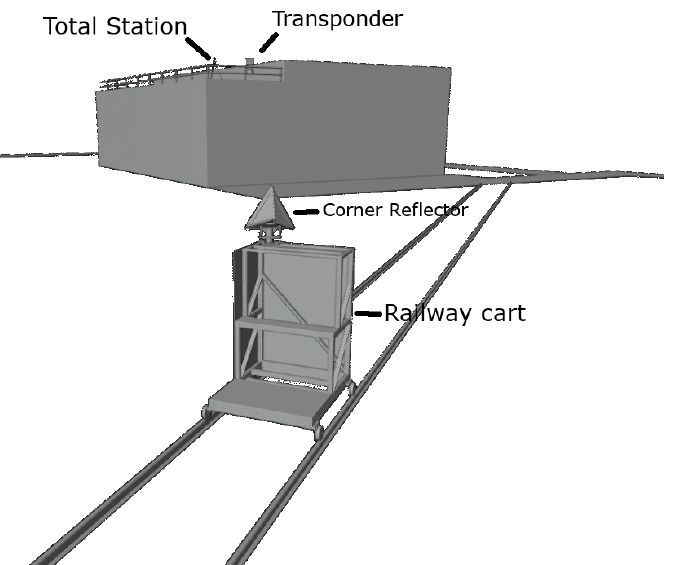
Figure 3. Illustration of the measurement geometry. Front: railway cart mounted with a corner reflector; back: building with measurement platform about 70 m away from the target.